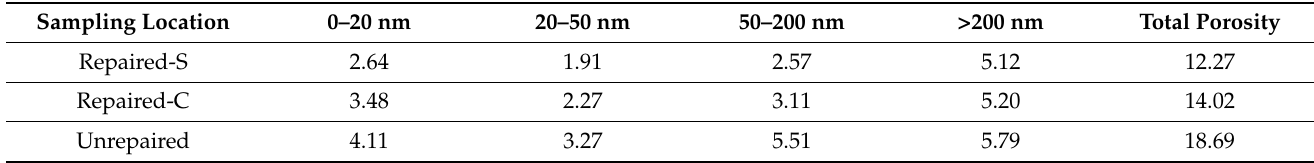
Figure 12. Pore size distribution of different samples. Table 4. Porosity distribution of different samples